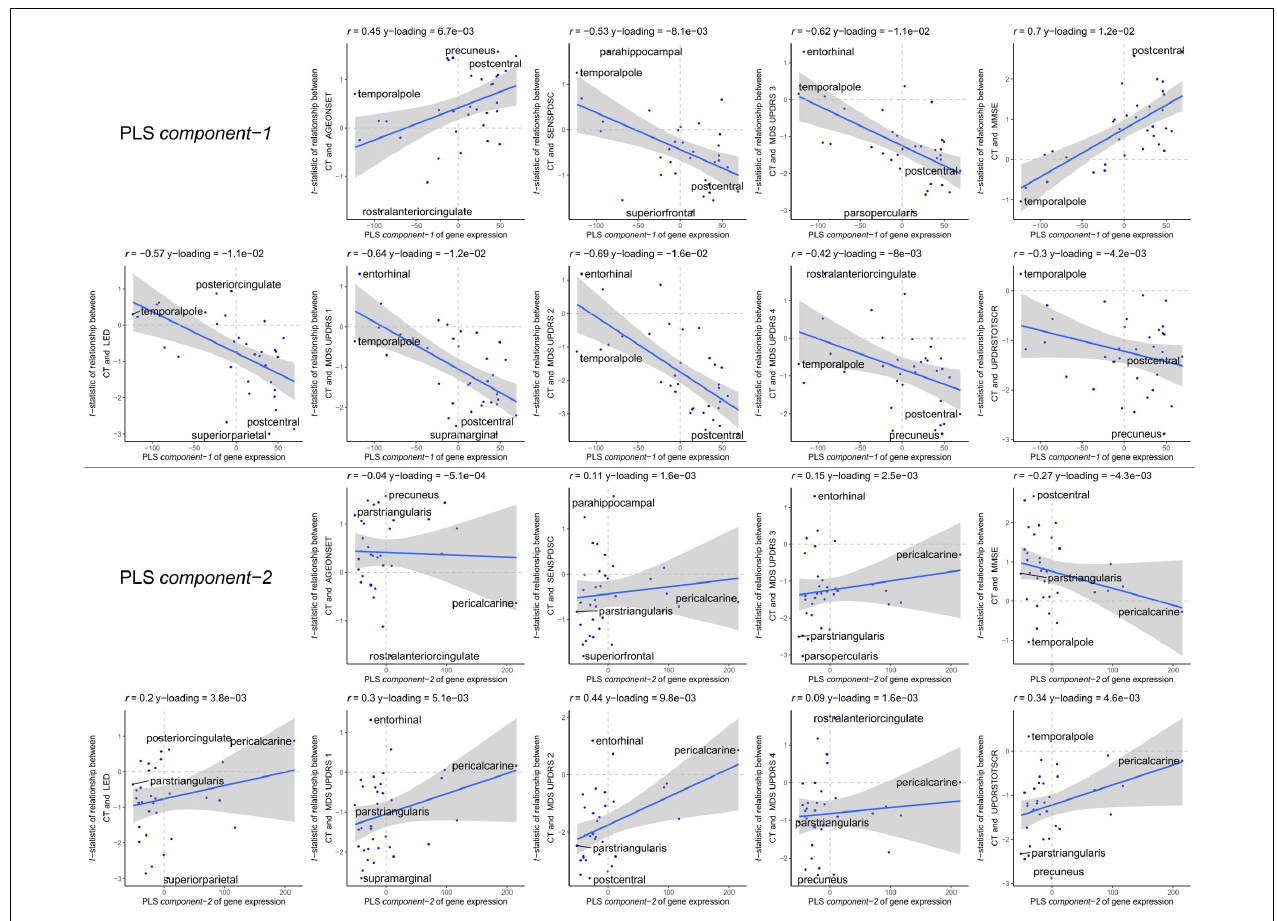
FIGURE 7 | Correlations between PLS model-2 component-1 and component-2 scores of the predictor variables and individual response variables. Each plot shows the correlation between the predictor variables of gene expression ( x -axis) and the response variables which are the relationships between CT and scores of a clinical feature across cortical regions ( y -axis). On top of each plot, the Pearson correlation and the Y-loadings (Q in Eqs. 4 and 8) are shown; both values tell something about the sign ( − / + ) and magnitude (high/low) of the correlation. Each point or sample is one of the 34 cortical regions. Regions are labeled for those with minimum or maximum value along one of the